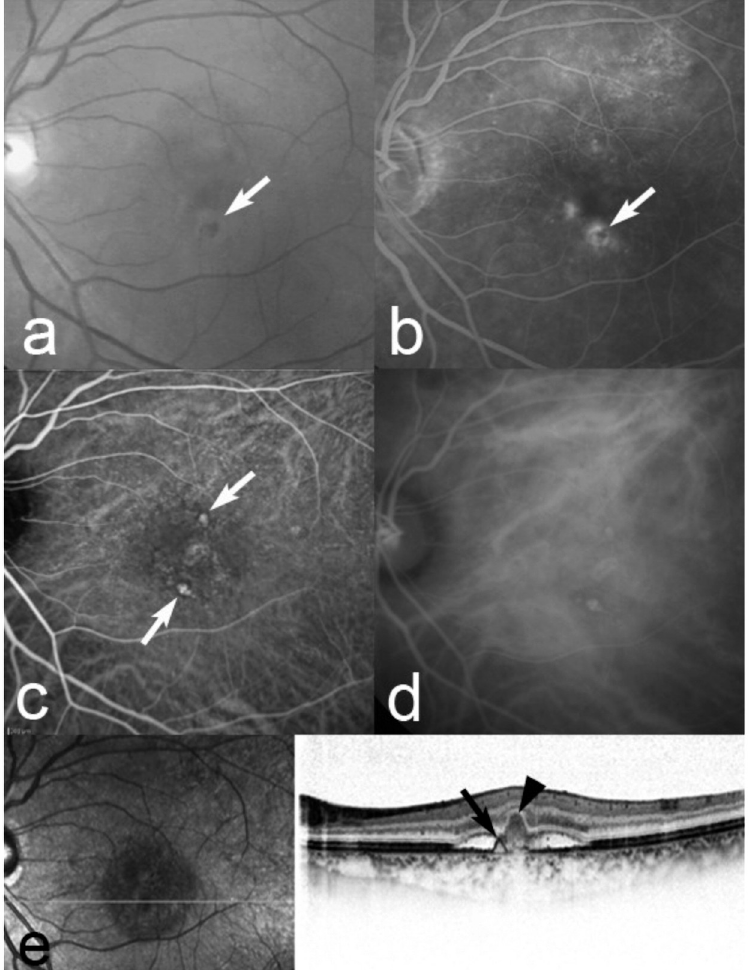
Fig 8. A 69-year-old man with fibrin associated with polypoidal choroidal vasculopathy. At baseline, the best- corrected visual acuity (BCVA) is 1.0 decimal VA (Snellen equivalent, 20/20) in the left eye. (a) A red-free fundus photograph shows an orange-red lesion surrounded by grayish-white fibrinous exudates (arrow). (b) Fluorescein angiography (FA) shows leakage from fibrin (arrow). Early-phase (c) and late-phase (d) indocyanine green angiography (ICGA) images clearly show polypoidal lesions (arrows). A horizontal (e) optical coherence tomography image shows a serous retinal detachment and anterior protrusion of a highly reflective retinal pigment epithelium (RPE) line (arrow), which corresponds to the polypoidal lesions on ICGA. A B-scan image also shows grayish-white fibrinous exudates as highly homogenous reflective masses bridging the neurosensory retina and the RPE (arrowhead), which corresponds to fibrinous exudates on biomicroscopy and